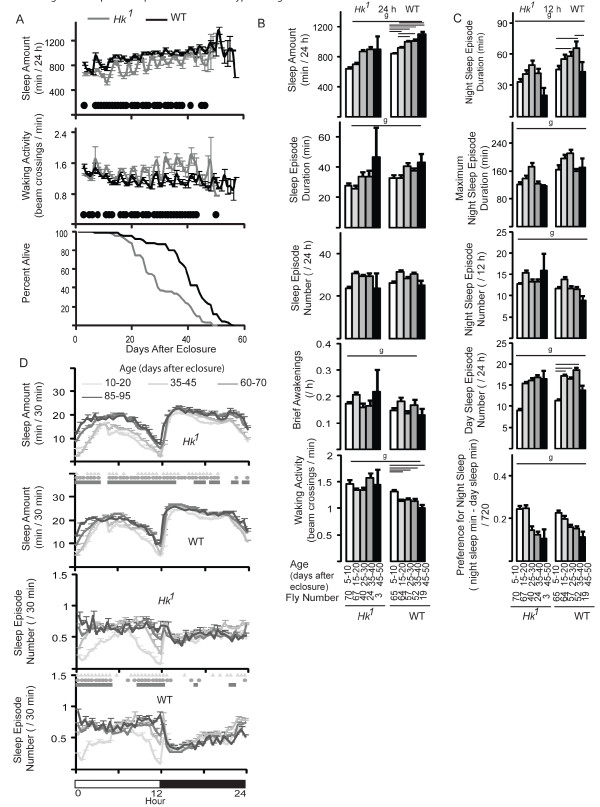
Sleep and lifespan in Hk1 and wild-type siblings reared and tested at 25°C. A. Twenty-four hour values of sleep and waking activity from eclosure to death and survival curves. Circles represent significant differences (Mann-Whitney test; p < 0.05) B. Sleep parameters (24-hour values) at different ages. C. Sleep parameters during night and day. Age range and number of flies are shown below each bar. Genotype (g) effects were tested across all ages (Kruskal-Wallis test, p < 0.05). Horizontal bars indicate significant age-related effects within each genotype (Friedman test followed by Wilcoxon signed-rank test, p < 0.05). D. Time course of sleep parameters in 30-min bins. Comparisons (Friedman test followed by Wilcoxon signed-rank test, p < 0.05) are between the 10-20 day period and all following ages: triangle (vs 35-45), circle (vs 60-70), square (vs 85-95).